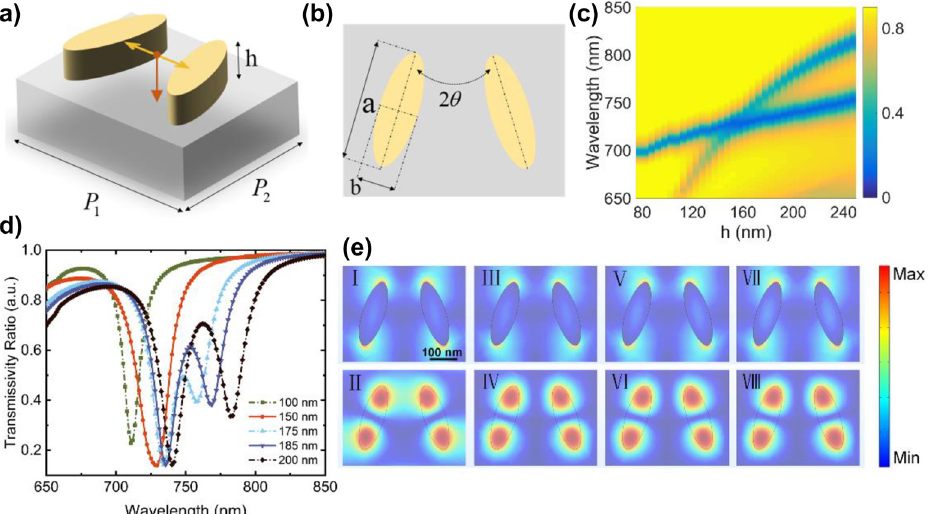
Figure 2: Transmission spectra and electric fields of the initial metasurfaces containing two nanopillars in one period. (a) And (b) schematic diagrams of the initial arrangements of the elliptical nanopillars. Specifically, a = 240 nm, b = 80 nm, 𝜃 = 17.5 ◦ , P of the transmission spectra on the height of the nanopillars. (d) Transmission spectra of five metasurfaces containing nanopillars of 100 nm, 150 nm, 175 nm, 185 nm, and 200 nm height, respectively. (e) The corresponding electric fields of the eigenmodes in accordance with